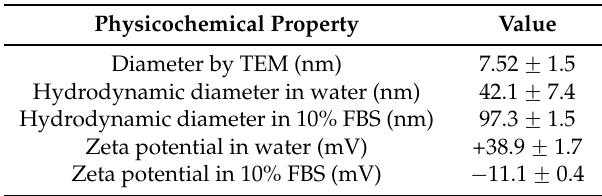
Figure 1. Analysis of the properties of the TNPs. ( A ) TNPs was dispersed by ultrasonication for half an hour and the morphology of the TNPs was observed under a transmission electron microscope; ( B ) The crystalline structure of TNPs was analyzed by X-ray diffraction. Table 1. The Physicochemical Properties of TNPs.